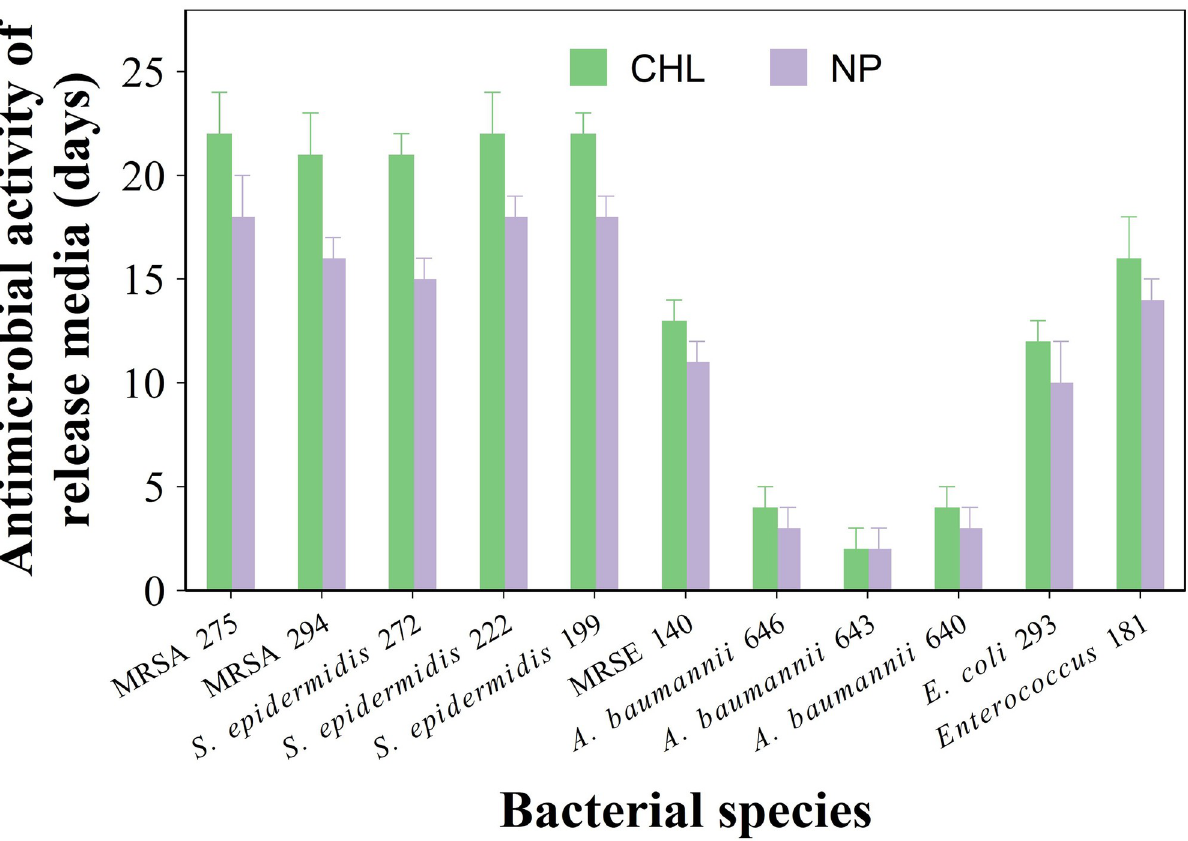
Fig 4. Antimicrobial activity of bone cement. Duration of antimicrobial activity against gentamicin resistant clinical isolates of PJI of Cemex with 3% w/w chlorhexidine either as pure powder or in coated NPs (mean ± SE, n = 6).